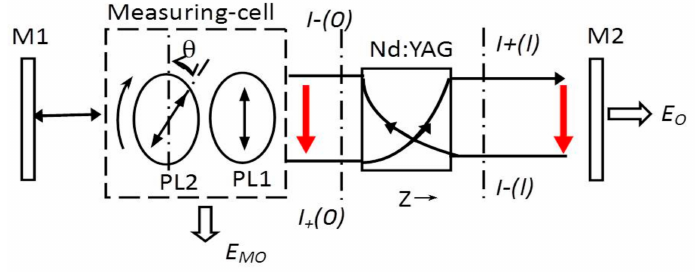
Figure 2. Schematic of measurement by introducing polarization reflective